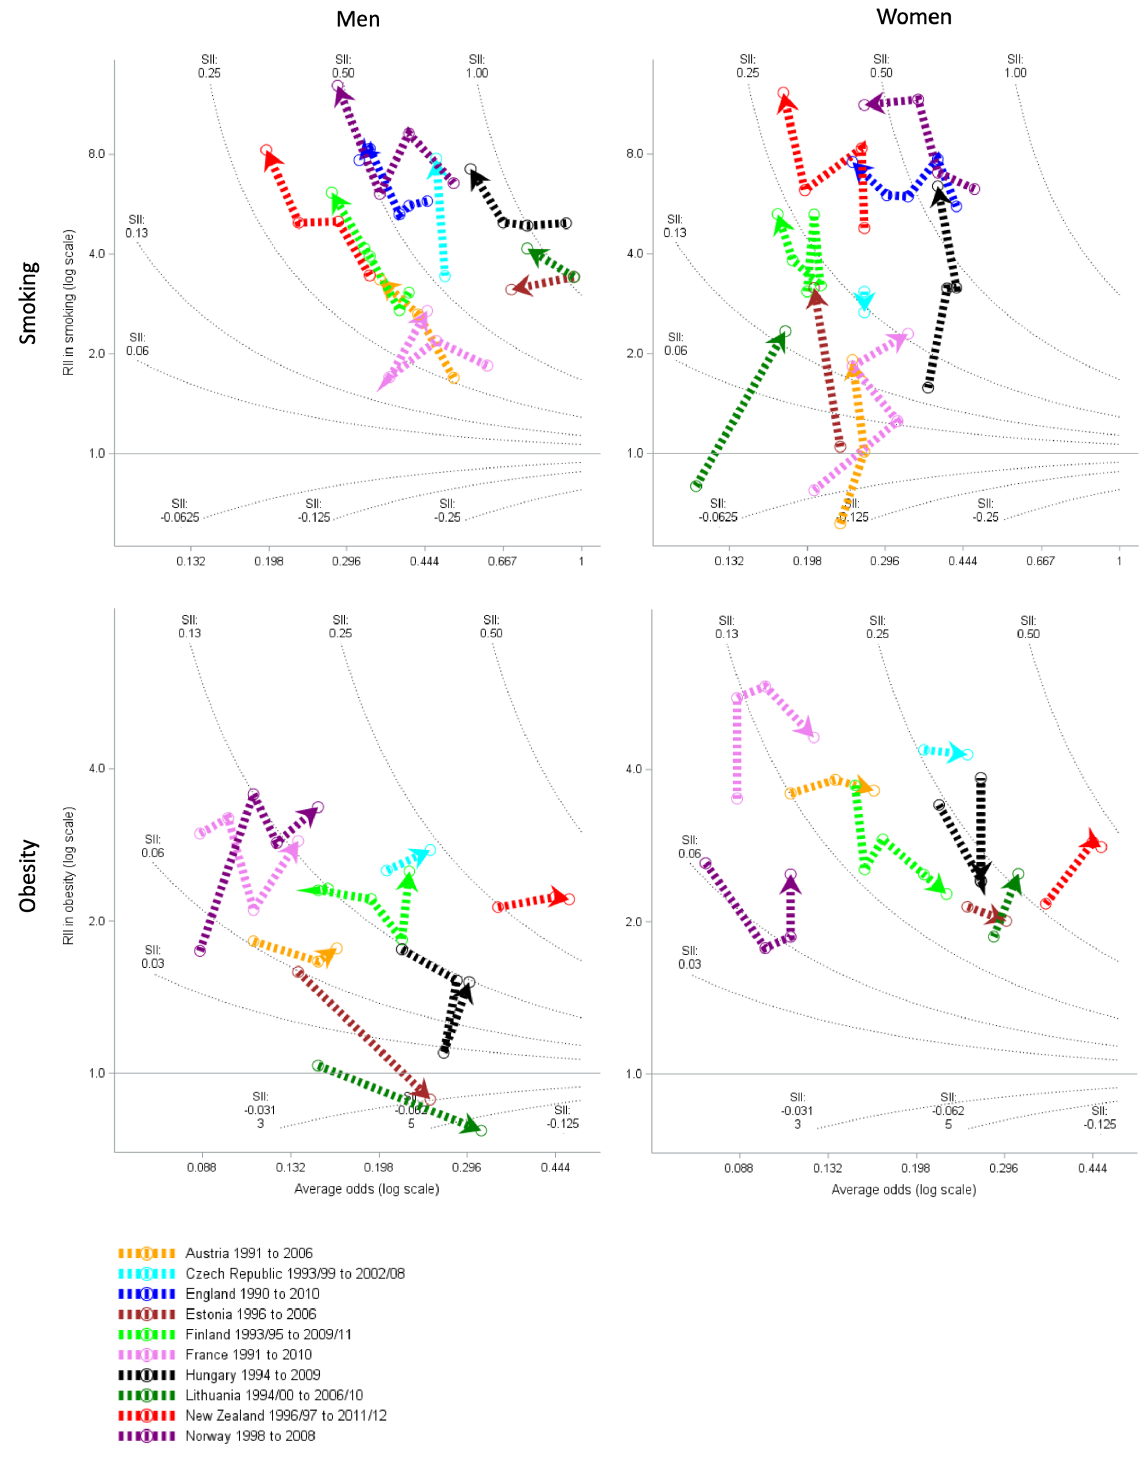
Fig 1. Trends and education inequalities in smoking prevalence (above) and obesity prevalence (below) 1990–2010. All countries had 1990s and 2000s data for smoking. For obesity NZ had only 2002/03 data and onwards, and England had no data, but all other countries had at least one time point from the 1990s and 2000s decade. Relative inequalities are measured by relative index of inequality (RII) on the log scale, and absolute inequalities by the slope index of inequality (SII) indicated by the contour lines.